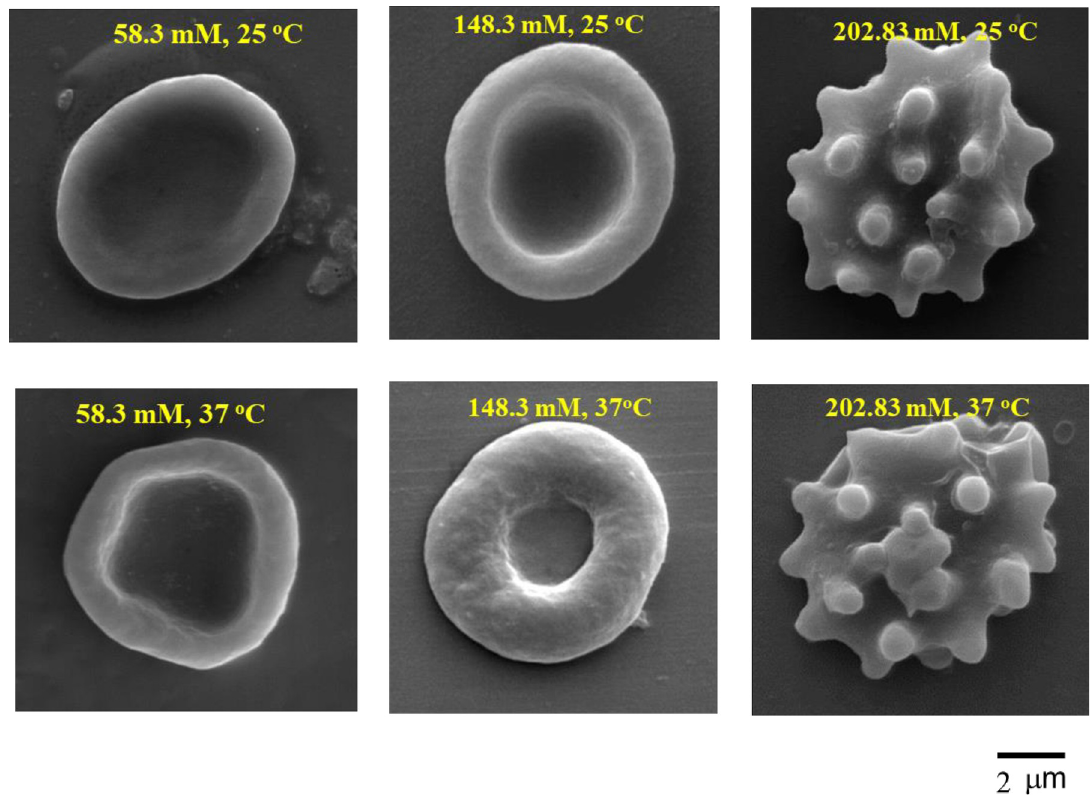
Fig 4. Electron micrographs of HRBCs shapes in 3 selected suspending solutions of isotonic solutions containing [Na + ] of 58.4 and 148.3 mM and hypertonic solution (202.83 mM). Normal erythrocytes left and centre, echinocytes on right. Normal erythrocytes closely approximate a Cassini